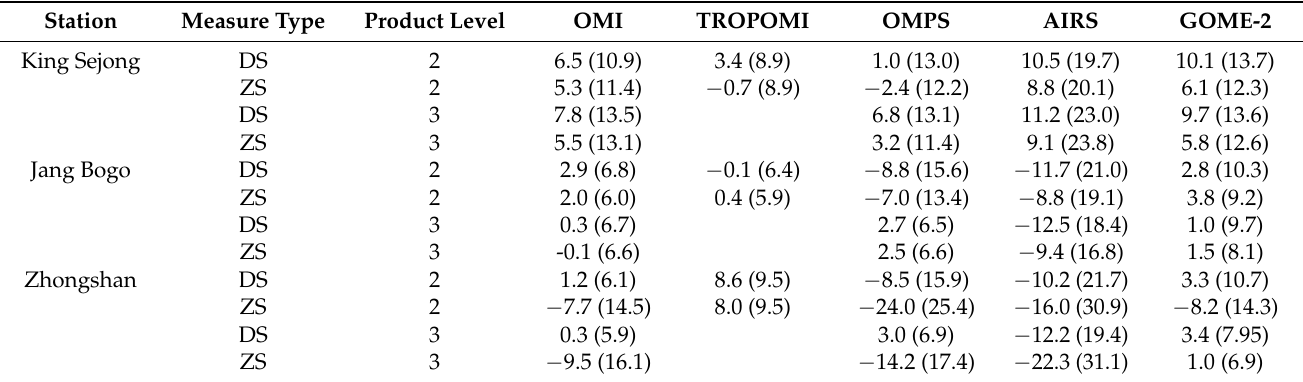
Table 2. The MBE (MABE) values for satellite data at each station (unit: DU). Since TROPOMI does not provide Level 3 data, the value does not exist, so all tables are marked with blanks.